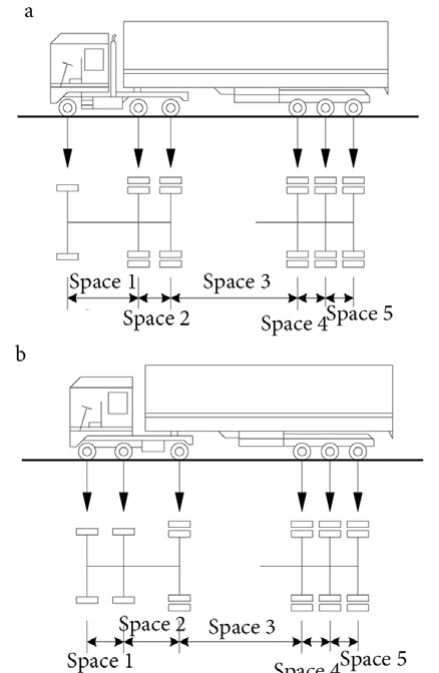
Fig. 13. Typical axle-type for 6-axle vehicle: a – 1-2-3 axle type; b – 2-1-3 axle